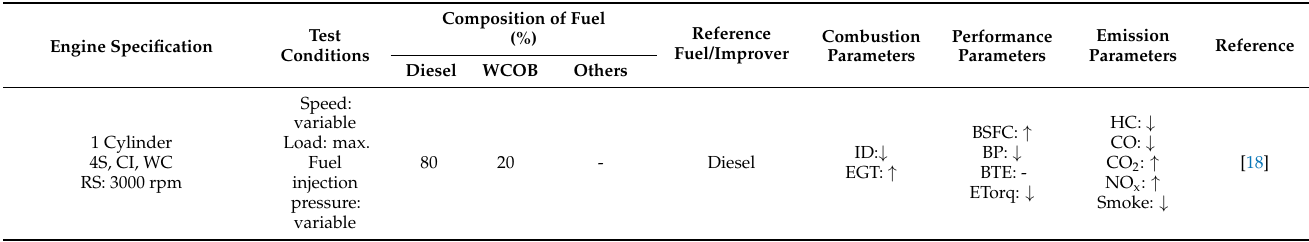
Table 6. Summary of the combustion, performance, and emission parameters of a diesel engine using diesel and a waste cooking oil